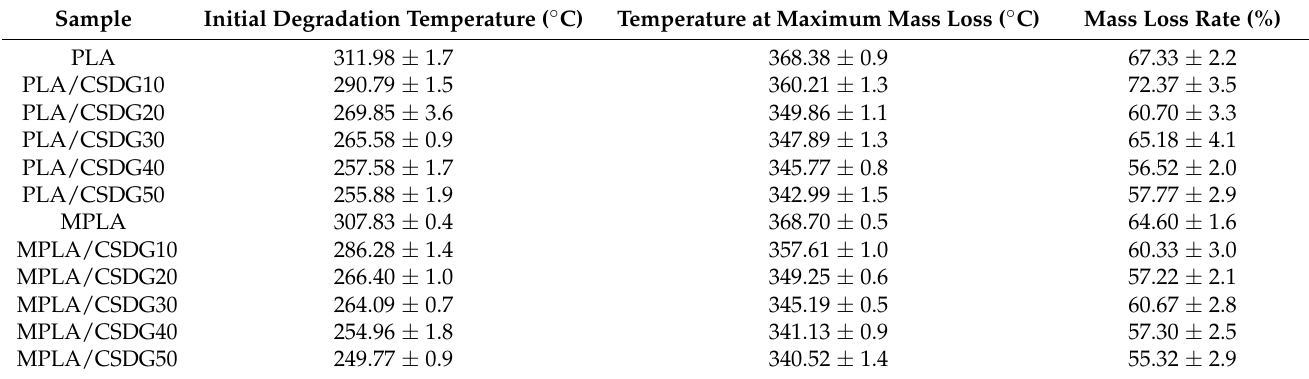
Table 4. Differential thermogravimetric data for PLA, PLA/CSDG, MPLA, and